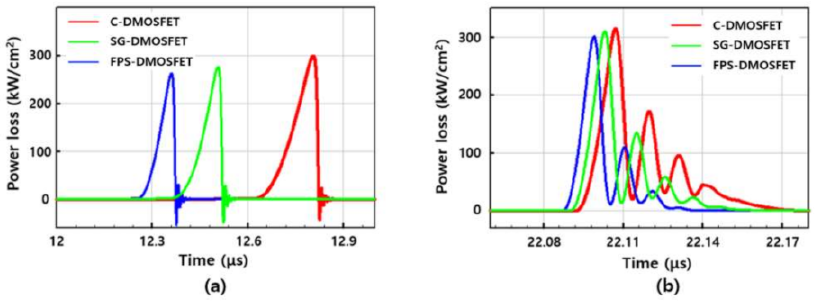
Figure 15. The switching power loss of three structures extracted by double pulse test. ( a ) turn off transient and ( b ) turn on